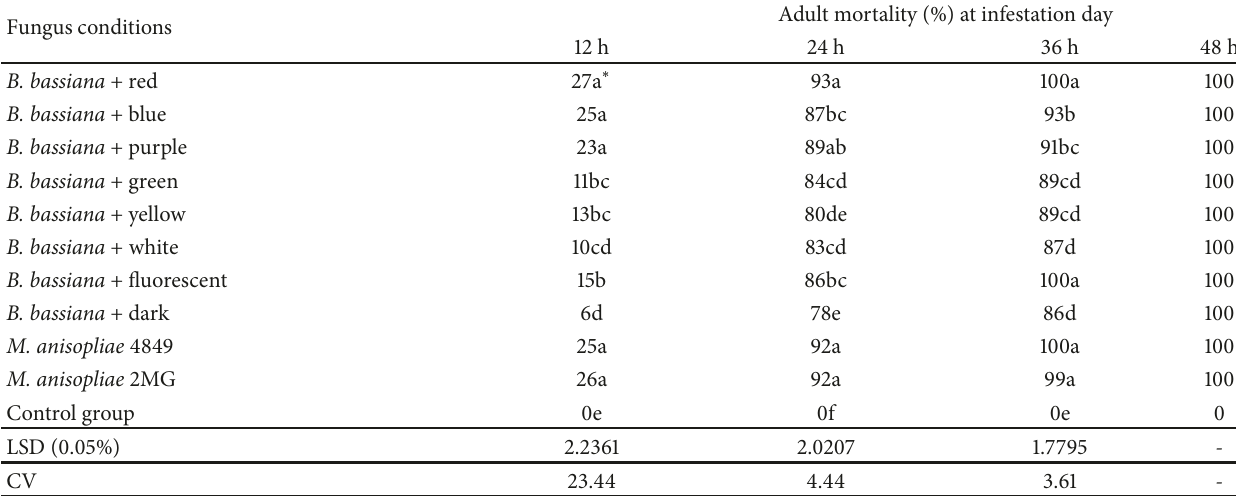
Table 1: The ability of aerial conidia of B. bassiana isolate BCMU4 produced under LED lights to control Ctenocephalides felis . Fungus